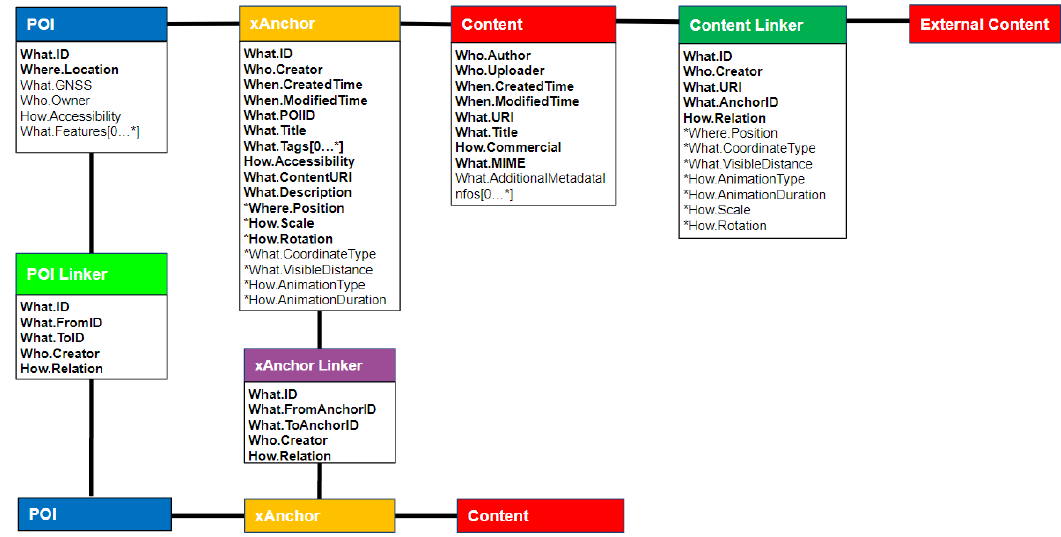
Figure 1. Point of Interest (POI)-extended anchor (xAnchor)-content structure based on the 5W1H model-based metadata (The attributes used in this study are shown in bold letters).